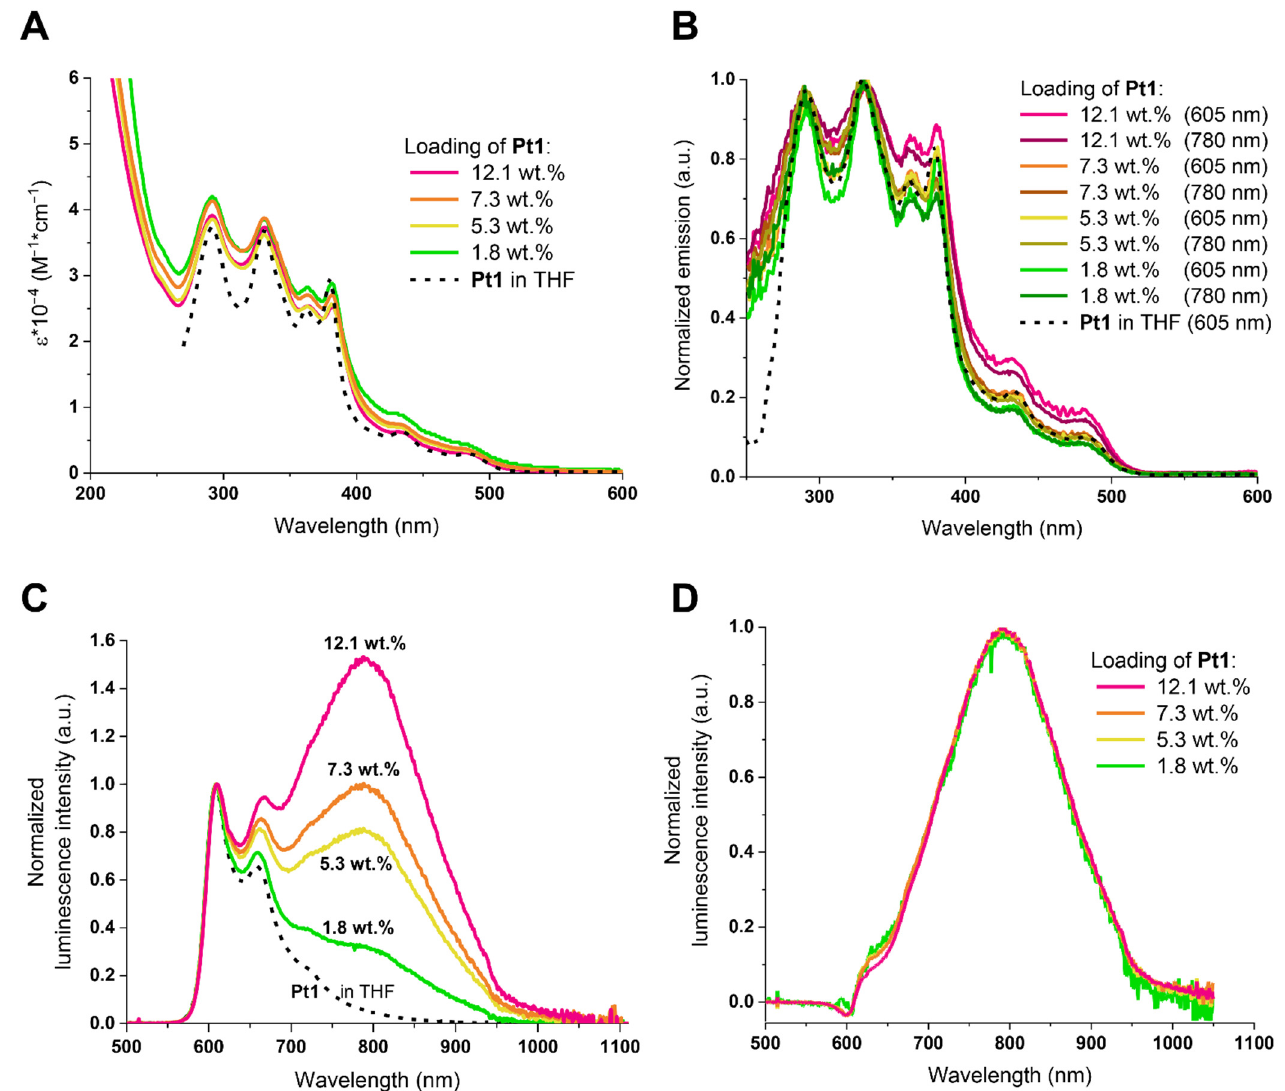
Figure 2. Photophysical properties of Pt1@PCL- b -PEG micellar dispersions in water. ( A ). Absorption spectra. ( B ). Normalized excitation spectra detected at 605 and 780 nm. ( C ). Normalized emis- sion spectra. Excitation at 365 nm. Dashed line represents emission spectrum of Pt1 in THF. ( D ). Normalized differential spectra of Pt1 NIR emission band in the PCL- b -PEG micelles.